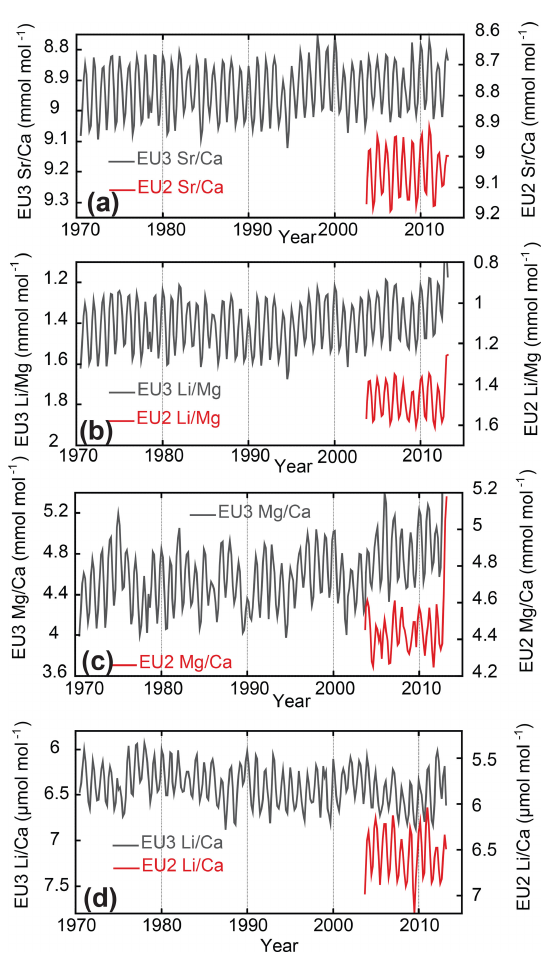
Figure 3. Bimonthly interpolated time series of trace element ra- tios in cores EU2 and EU3. (a) Sr / Ca, (b) Li / Mg, (c) Mg / Ca, and (d) Li /